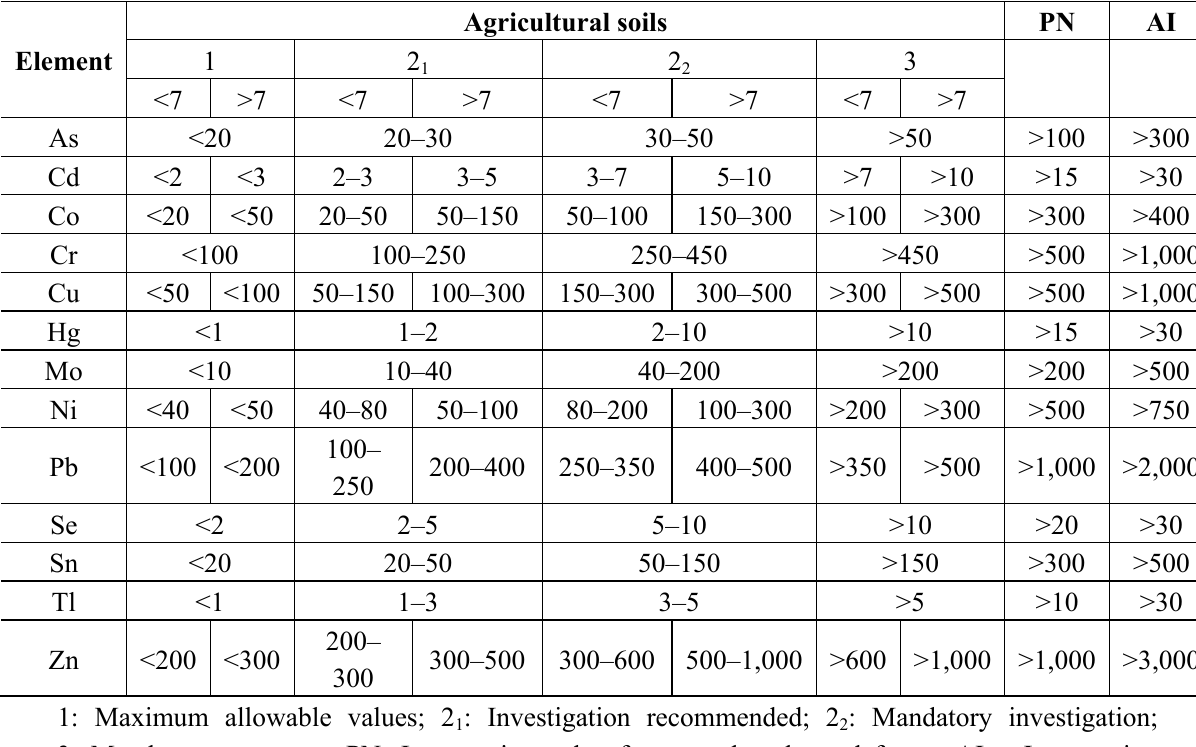
Table 6. Proposal for contaminant threshold of trace elements in the Andalusian Comunity [33] (Values refers to total concentration and are given in